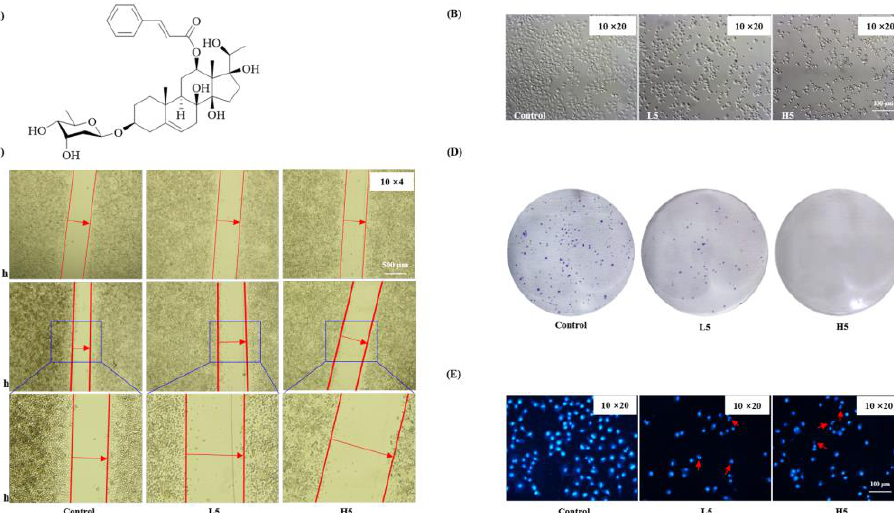
Figure 1. Compound 5 inhibited the migration and proliferation of HepG2 cells. L5, low concentration of 5 (12.5 µ mol − 1 ); H5, high concentration of 5 (25 µ mol − 1 ). ( A ) The structure of compound 5 . ( B ) The morphology of HepG2 cells was treated with 5 for 48 h. ( C ) The scratch test of 5 on HepG2 cells was detected for 36 h. ( D ) The colony test of HepG2 cells by 5 treatments was detected for 7 days. ( E ) Fluorescence images were detected by Hoechst staining. Red arrows pointed to the fragmented nucleus. The same concentrations of 5 were used in the following.